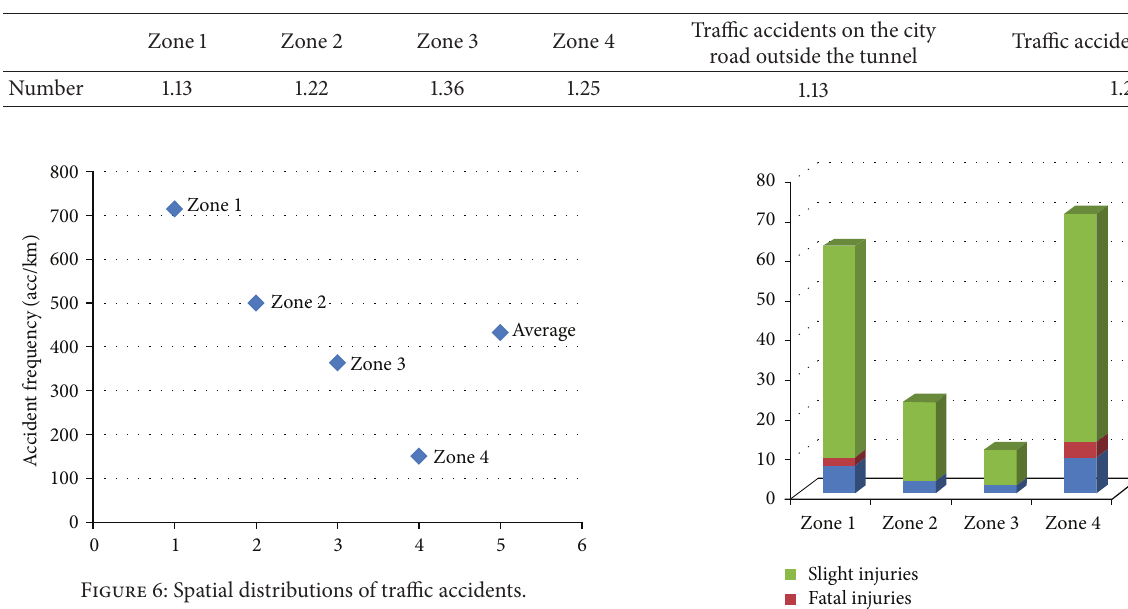
Table 1: Number of injured people per accident.